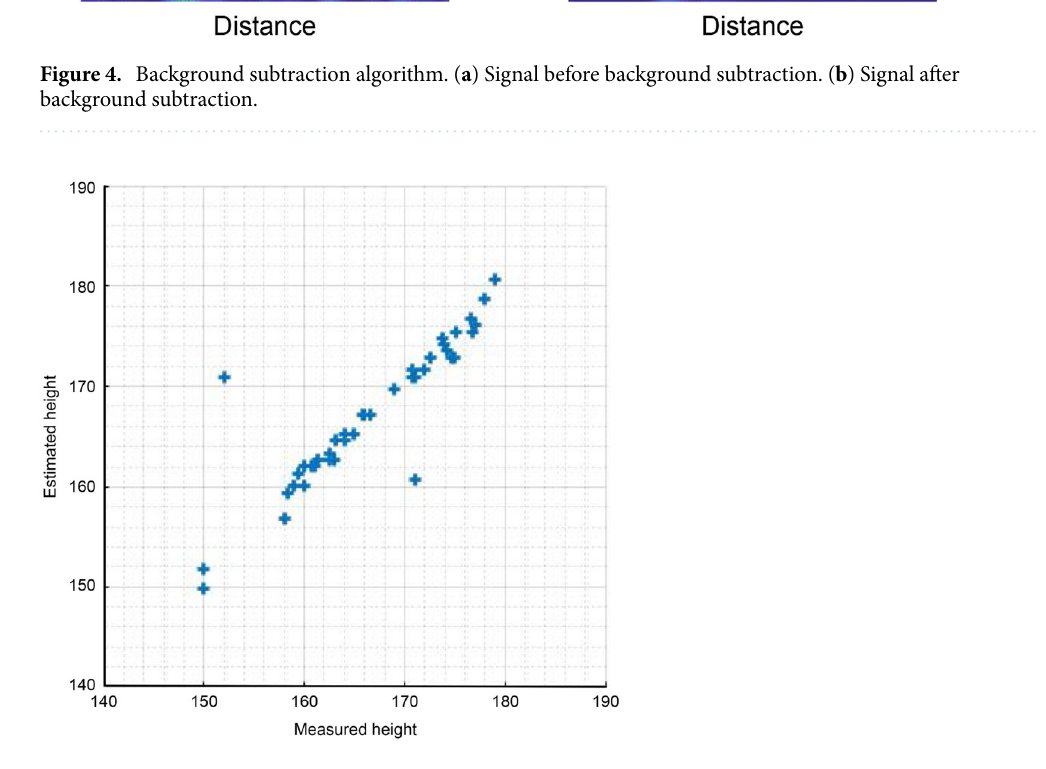
Figure 5. Comparison of estimated and measured height